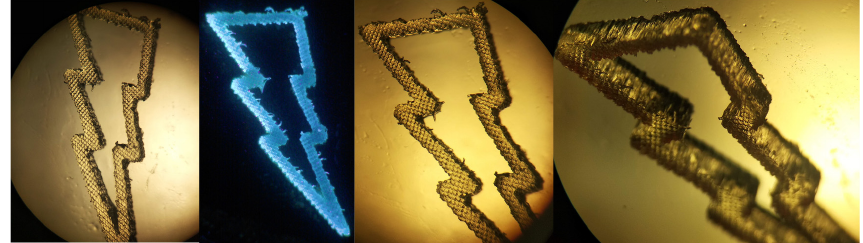
Figure 11. The pattern obtained after the 3D printing experiment based on formulation with T1 (0.07% w / w ) and TMPTA.